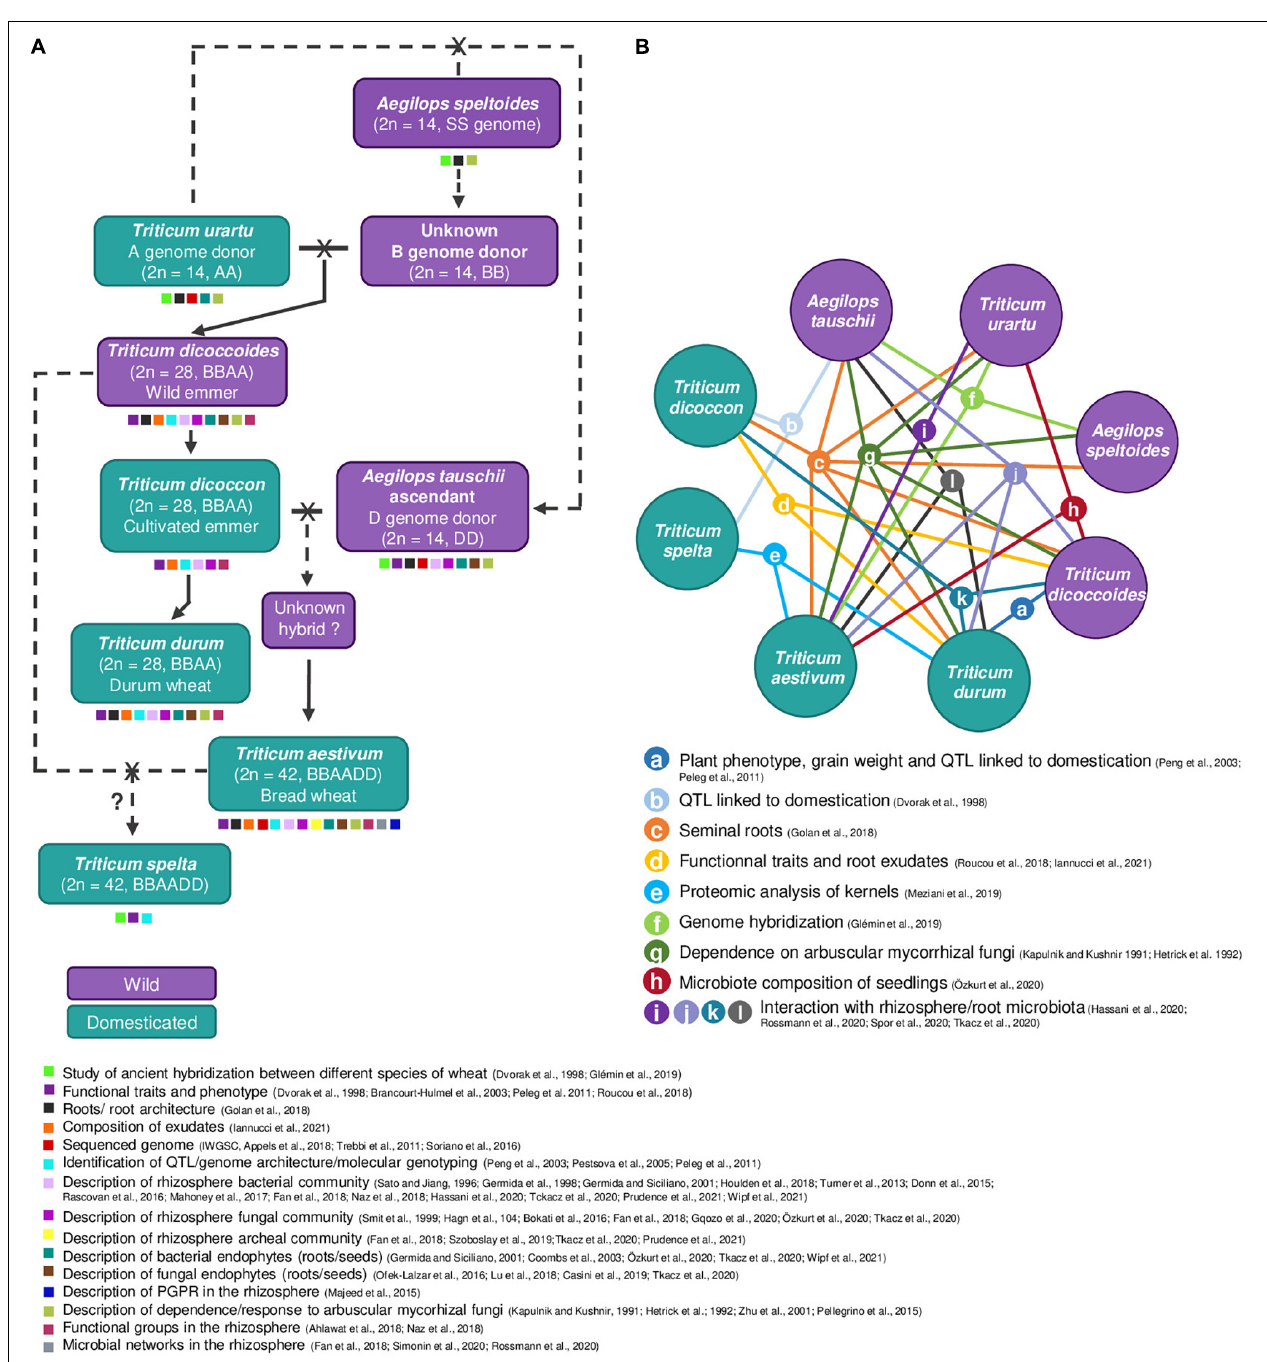
FIGURE 2 | The origin of durum and bread wheat, and literature comparisons. Wild wheats are represented in purple, while domesticated wheats are in turquoise. (A) Wild and domesticated species involved in wheat evolution and leading to pasta ( T. durum ) and bread ( T. aestivum ) wheats are indicated (adapted from Mujeeb-Kazi, 2006), as well as examples of key scientific issues investigated with them (shown with small squares with the color code indicated below the panel). The ancestors of pasta and bread wheats underwent hybridization and polyploidization events involving genomes A, S, B, and D. A simplified version of wheat evolutionary history is depicted. The A and S genomes arose by divergence from a common ancestor (not shown) circa 7 million years Before Present (BP) (Pont et al., 2019). The B genome probably descends from the S genome and is therefore a close relative of Aegilops speltoides (SS) (Fricano et al., 2014). A first hybridization event is speculated to have taken place between A ( T. urartu ) and S ( A. speltoides / A. mutica ) genomes, 5–6 million years BP (Glémin et al., 2019), leading to the D genome upon homoploid hybrid speciation. A second hybridization event took place about 500,000 years BP between this B genome